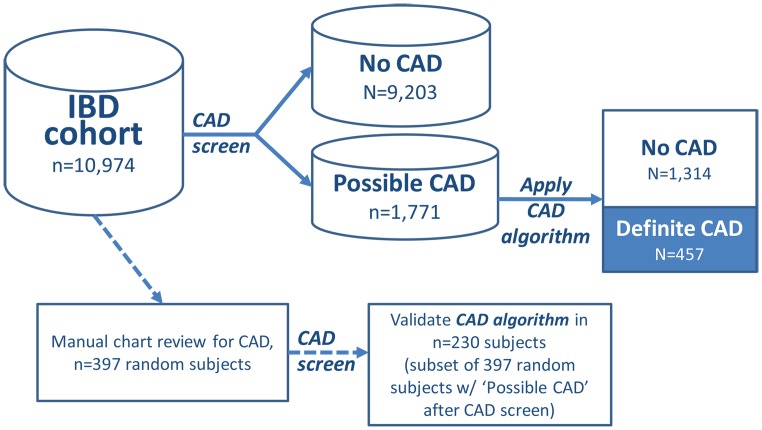
Validation of the CAD algorithm in the IBD cohort.